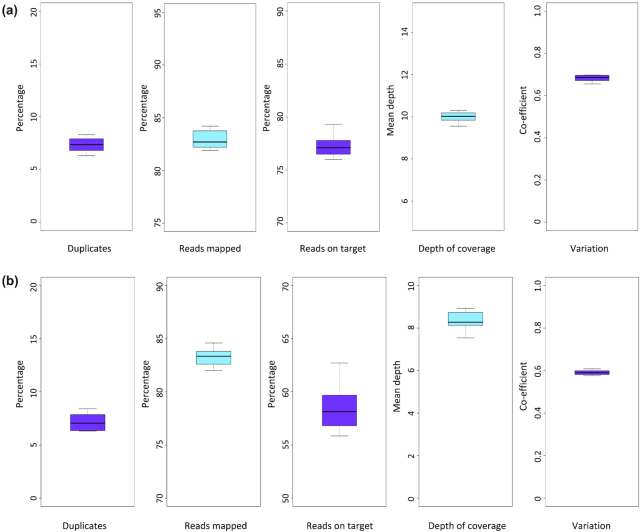
Summary statistics for the 8-plex gene and promoter capture tests. We performed read alignments for the 8 CIMMYT samples to the full Chinese Spring genome. For the (a) gene capture and (b) putative promoter capture probe sets, from left to right, we show box and whisker plots for the percentage of sequencing reads per sample that were identified as duplicates, the percentage of reads mapping uniquely to the whole genome reference sequence, the percentage of reads defined as “on target,” i.e., aligned to the capture probe design space, the mean depth of coverage per sample, and the coefficient of variation per sample.